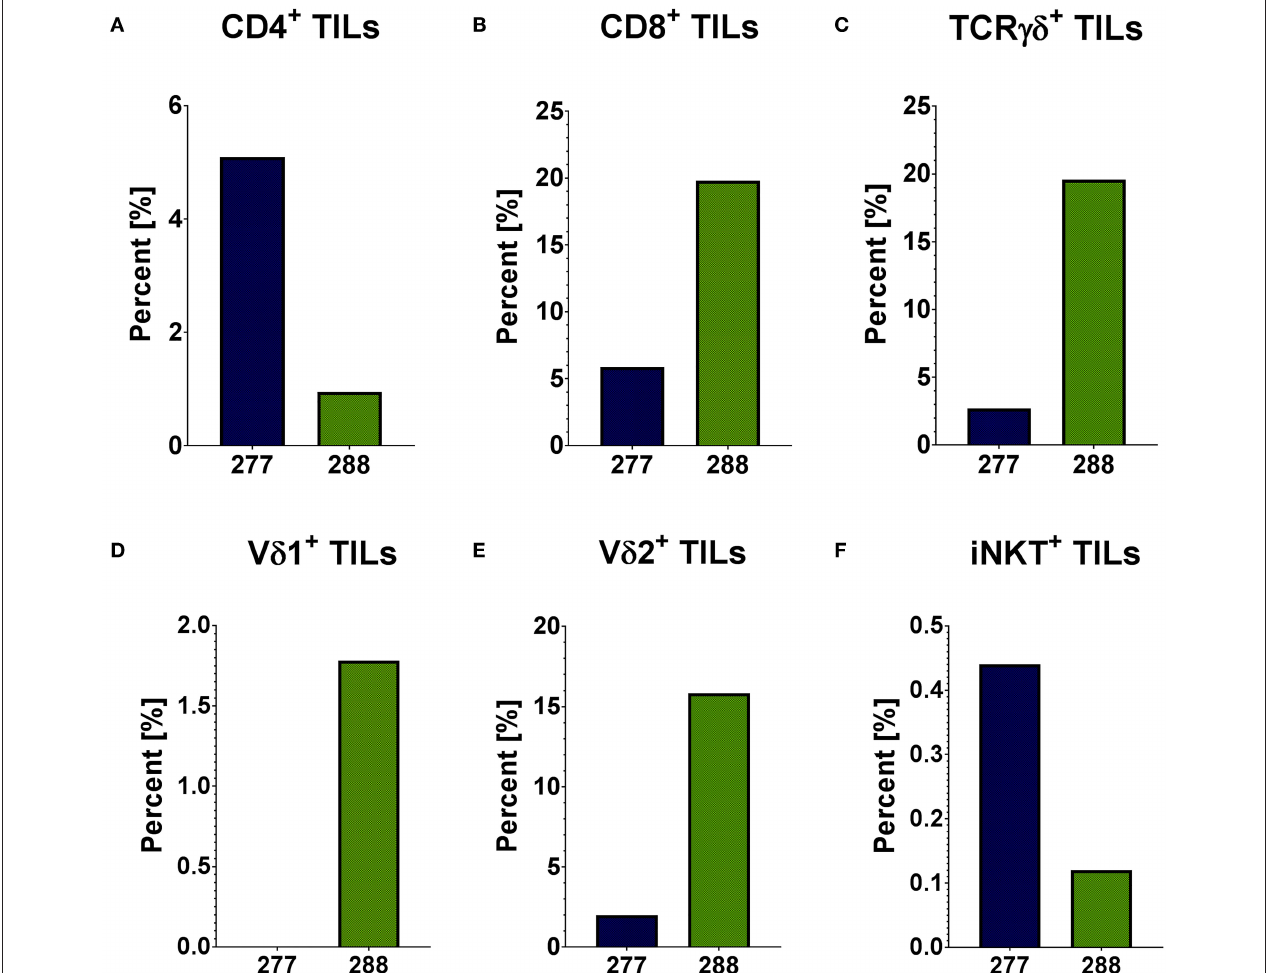
FIGURE 1 | Distribution of infiltrating T cells in PRCC tumor samples. Flow cytometric analysis was performed using specific antibodies against CD4, CD8, TCR γδ , V δ 1, V δ 2 and iNKT cell receptor. The distribution of different subpopulations within the lymphocyte population is shown. Both PRCC samples are infiltrated by conventional (CD4 + and CD8 + ) and unconventional ( γδ T-cells and iNKT-cells) T-lymphocytes. There is no infiltration of V δ 1 + T-cells in sample 277. (A) CD4 + T cells; (B) CD8 + T cells; (C) TCR γδ + T cells; (D) V δ 1 + T cells; (E) V δ 2 + T cells; (F) iNKT cells.